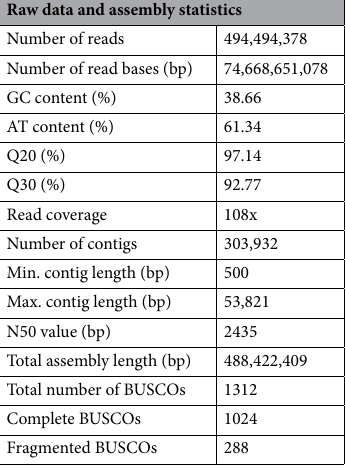
Table 1. Sequencing and assembly